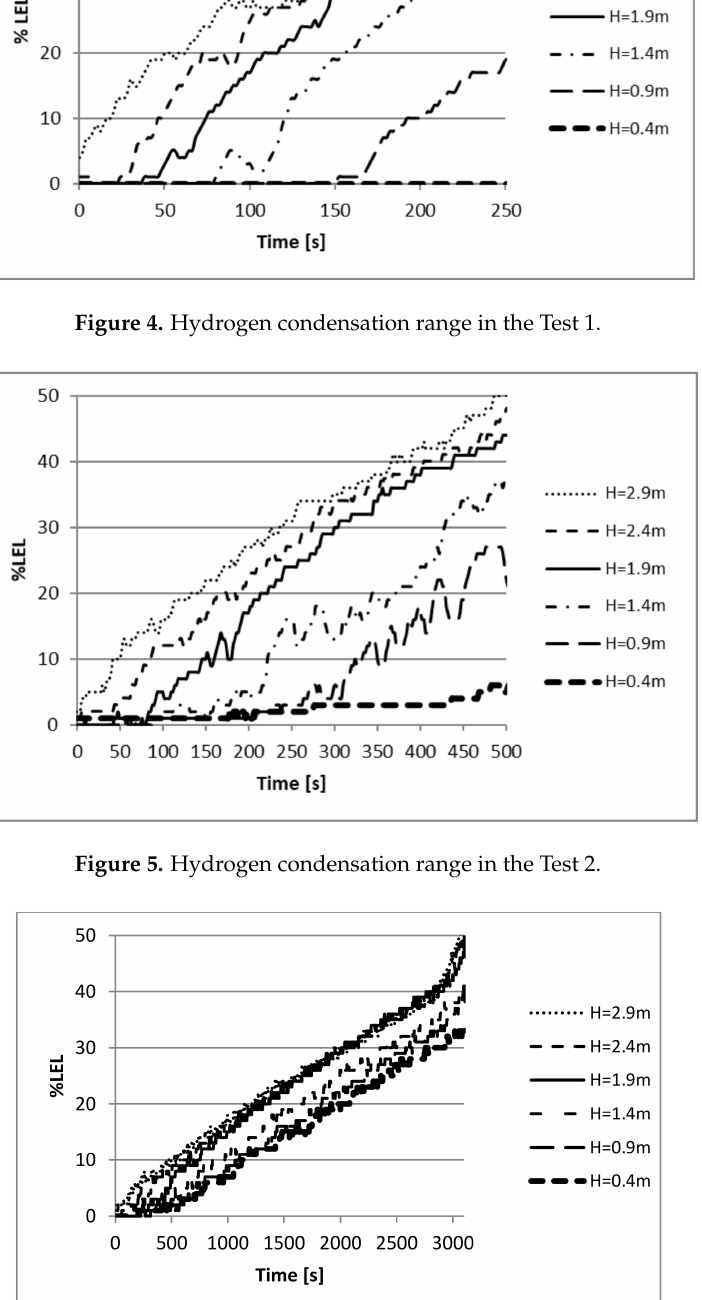
Figure 6. Hydrogen condensation range in the Test